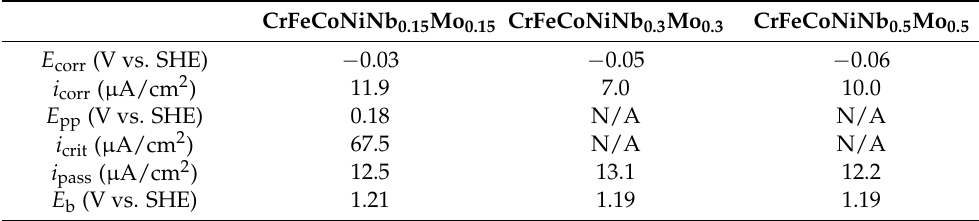
Table 3. Potentiodynamic polarization data of the as-cast CrFeCoNiNb x Mo x alloys in 1 M deaerated H 2 SO 4 solution at 30 ◦